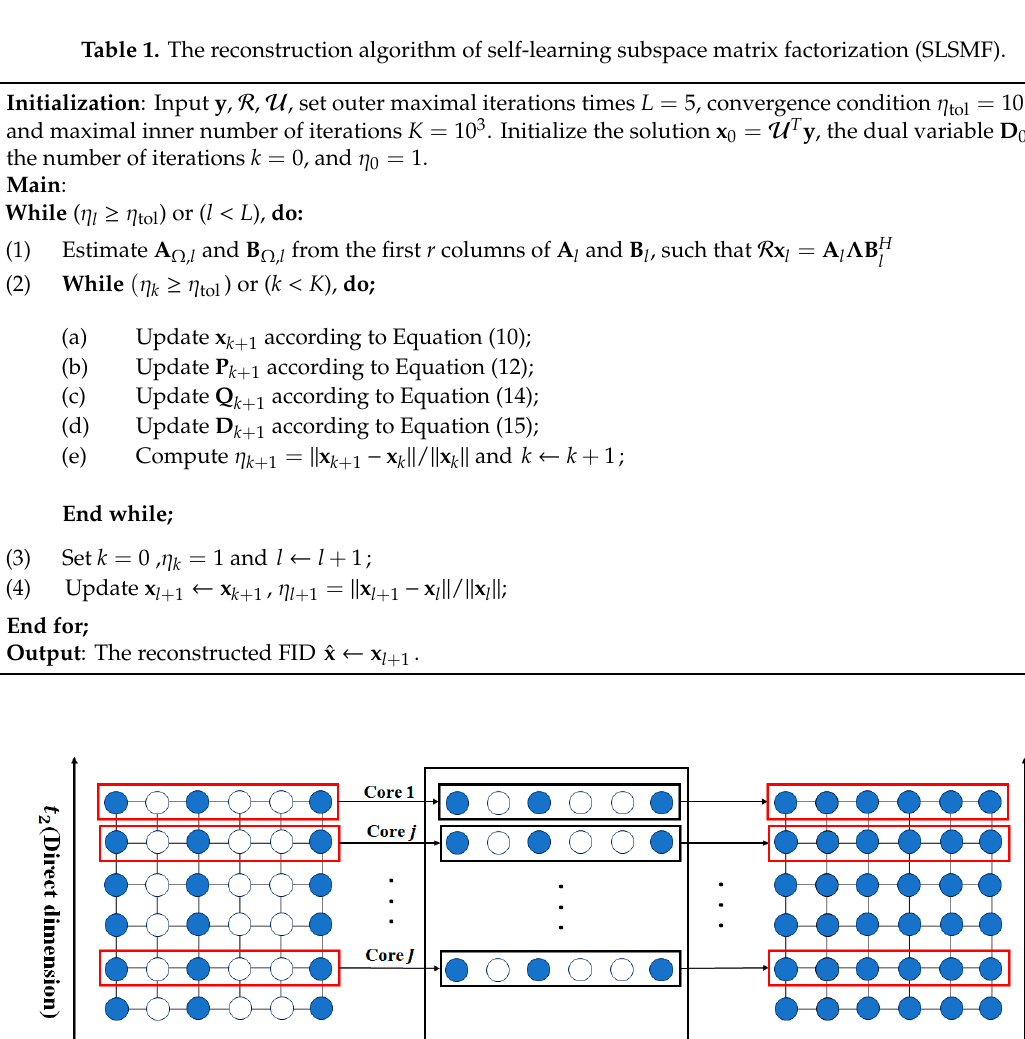
t ), and each 1D vector 1 t ) can be reconstructed 2